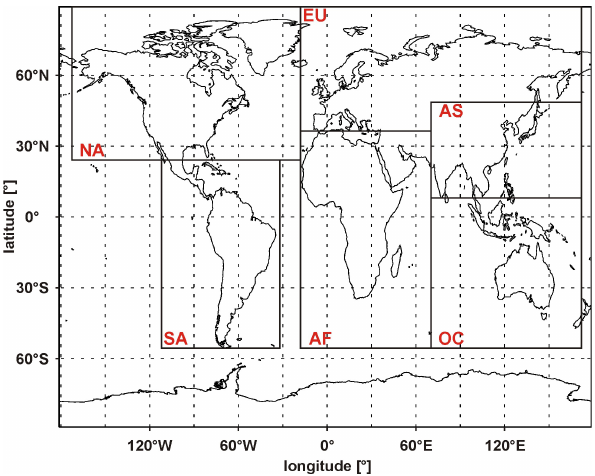
Fig. 3. Tropospheric source regions of the GEOS-Chem tagged-CO simulation. NA: North America, EU: Europe, AS: Asia, SA: South America, AF: Africa, and OC: Oceania.